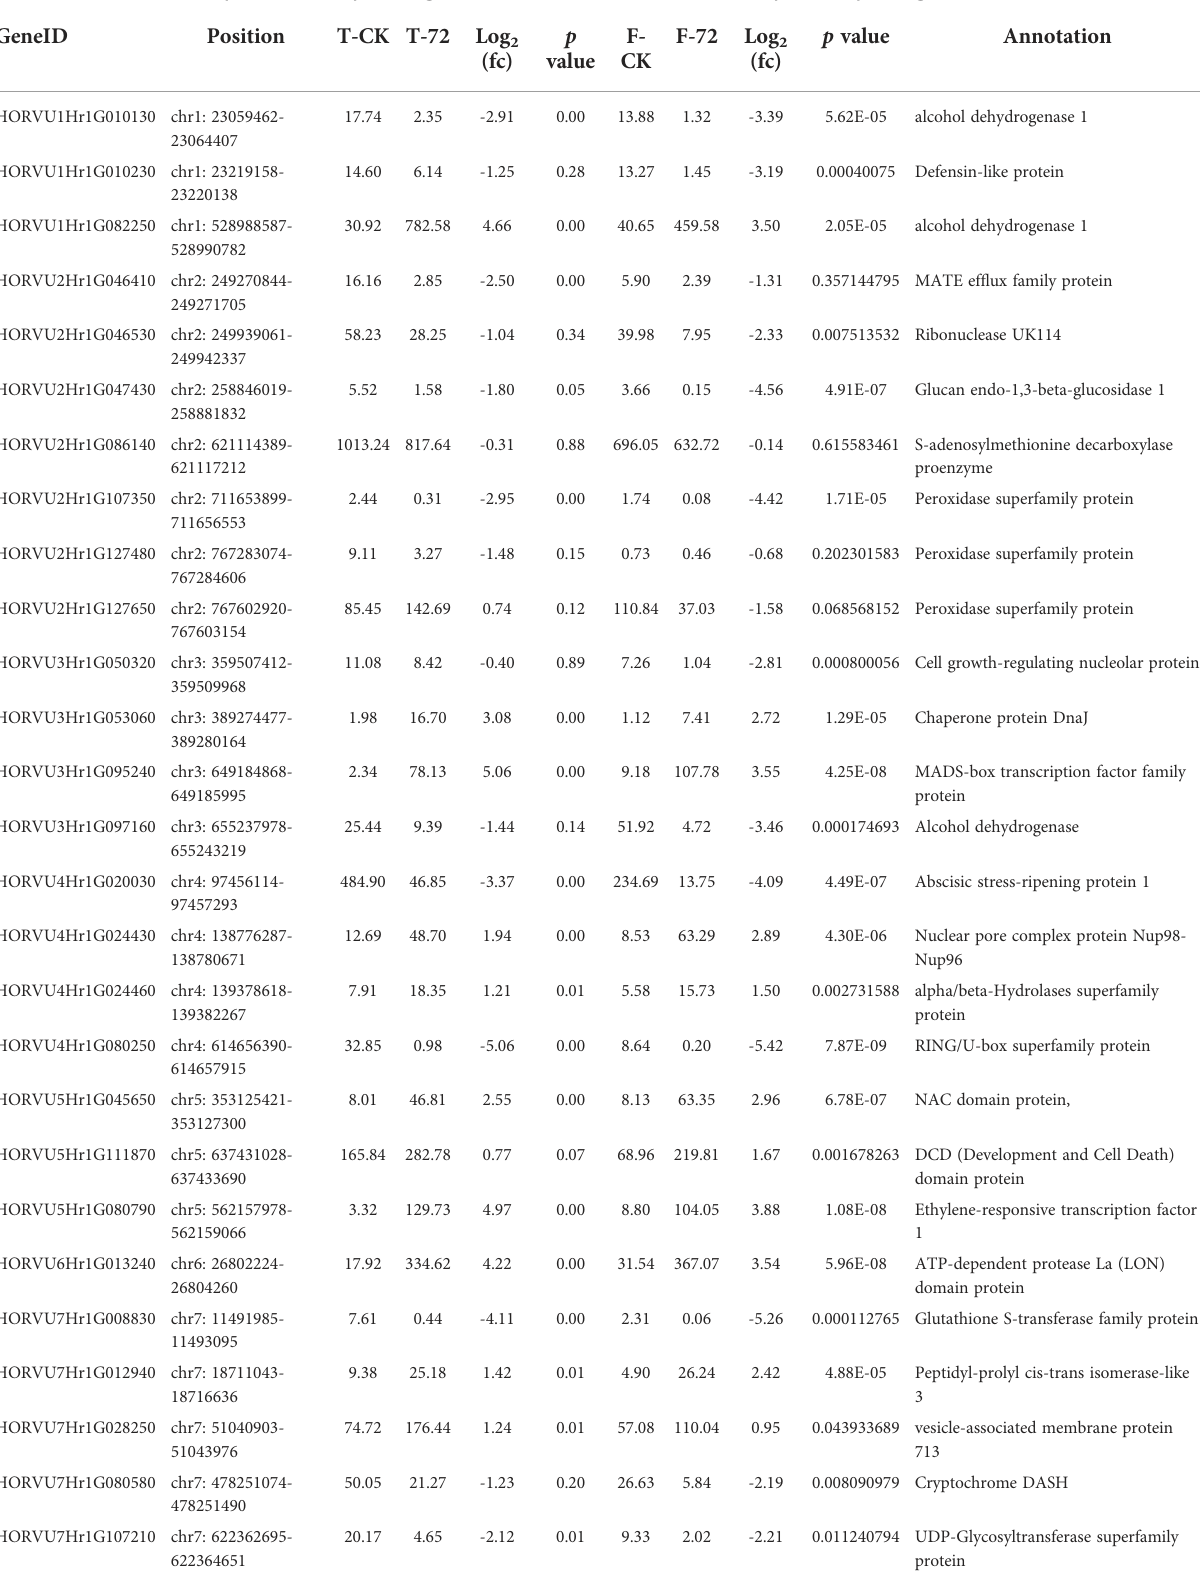
TABLE 4 The differential expression of the putative genes detected in both GWAS and transcriptome sequencing.